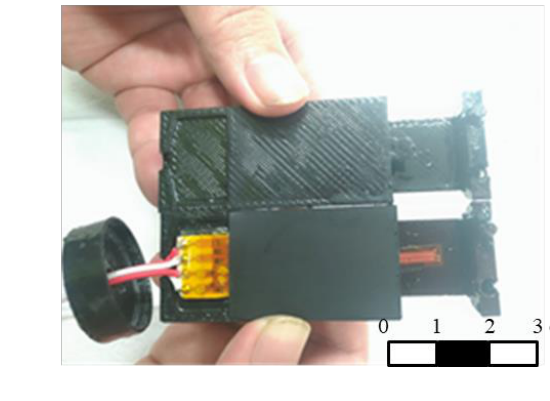
Figure 6. Tightness test.